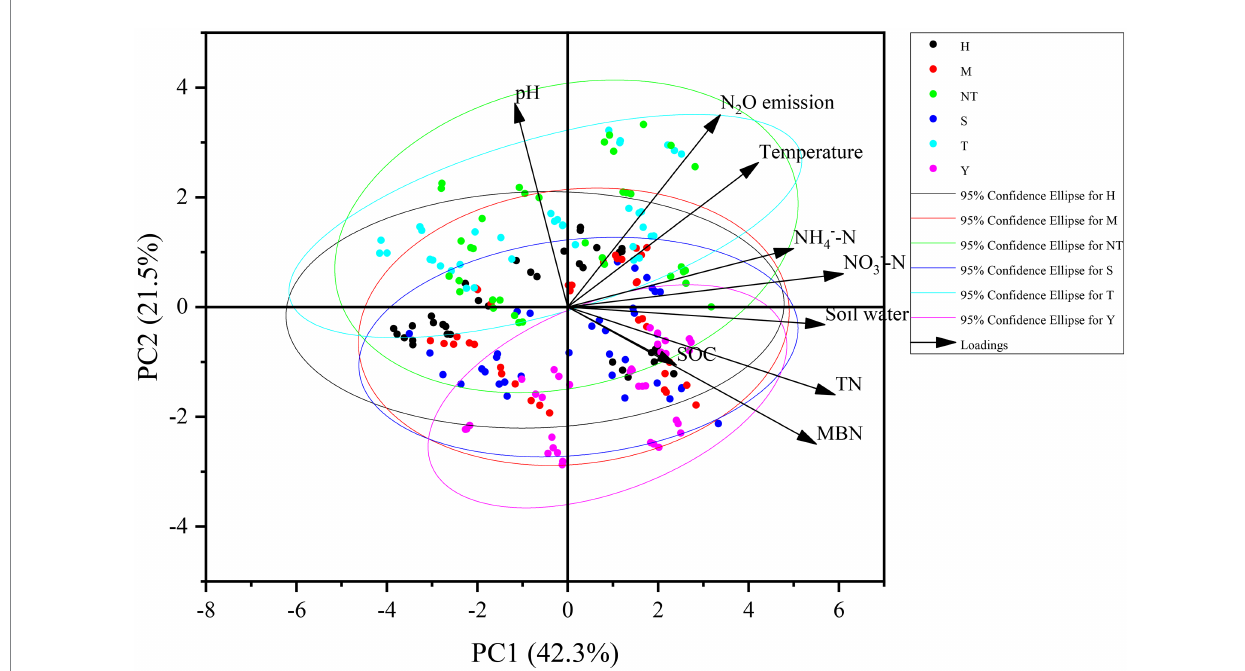
FIGURE 7 Principal component analysis of soil properties and N 2 O emission under land use patterns.